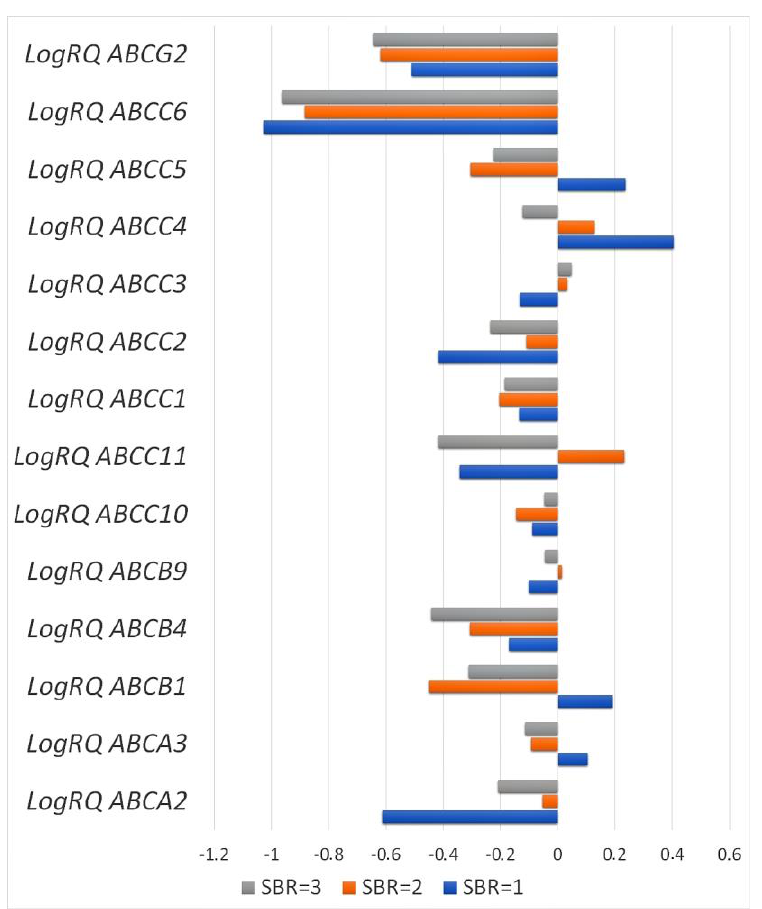
Figure 7. Mean expression values of selected genes from the ABC family in patients classified into the SBR1, SBR2, and SBR3 groups according to tumor stage (Scarff – Bloom and Richardson (SBR) scale). Table 2. Levels of statistically significant differences in the expression of the examined genes in patients classified into the SBR1, SBR2, and SBR3 groups (H Kruskal – Wallis test with multiple com- parison) and descriptive statistics. Statistically significant values are marked with *.